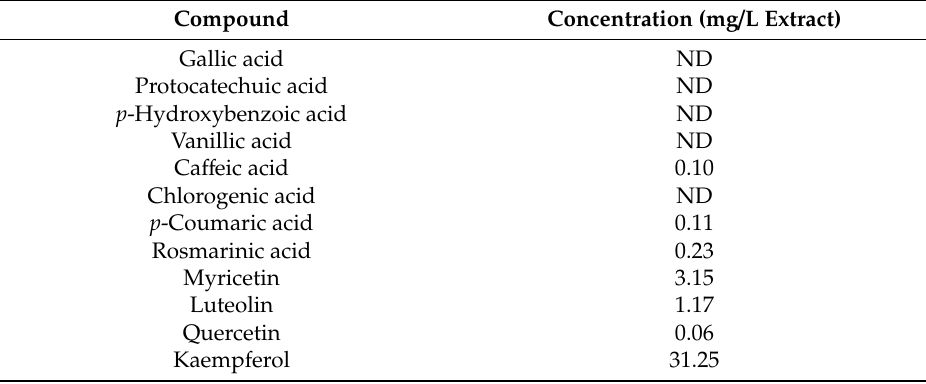
Table 5. Phenolic profile determined for the extract obtained under optimum extraction conditions. Compound Concentration (mg / L Extract) Gallic acid